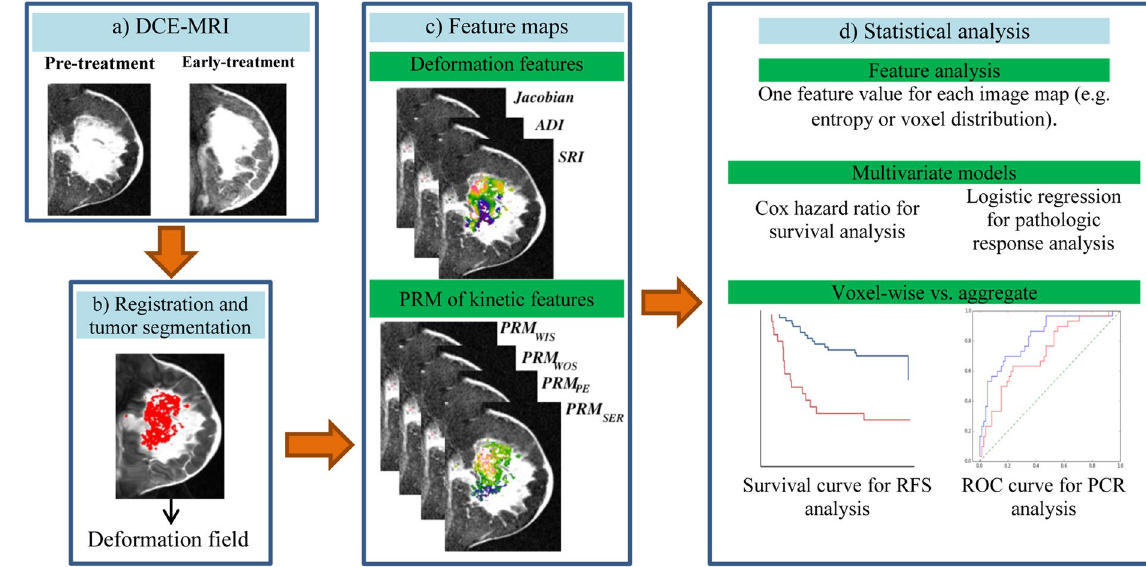
Figure 3. Outline of the process of voxel-wise analysis using deformable registration. ( a ) Acquiring DCE- MRI before and during neoadjuvant chemotherapy. ( b ) Applying deformable image registration to derive the transformation field, followed by segmentation of functional tumor volume. ( c ) Utilizing the deformation field for voxel-wise quantification of two groups of feature maps within the tumor: 1. Voxel-wise deformation features, including the Jacobian showing regional volume ratio and anisotropic deformation measures of directional deformation 2. Parametric response maps (PRM) showing kinetic feature variation. ( d ) Building multivariable models using the top voxel-wise feature values, and comparing their performance with that of the corresponding aggregate feature models in predicting recurrence-free survival (RFS) and pathologic complete response